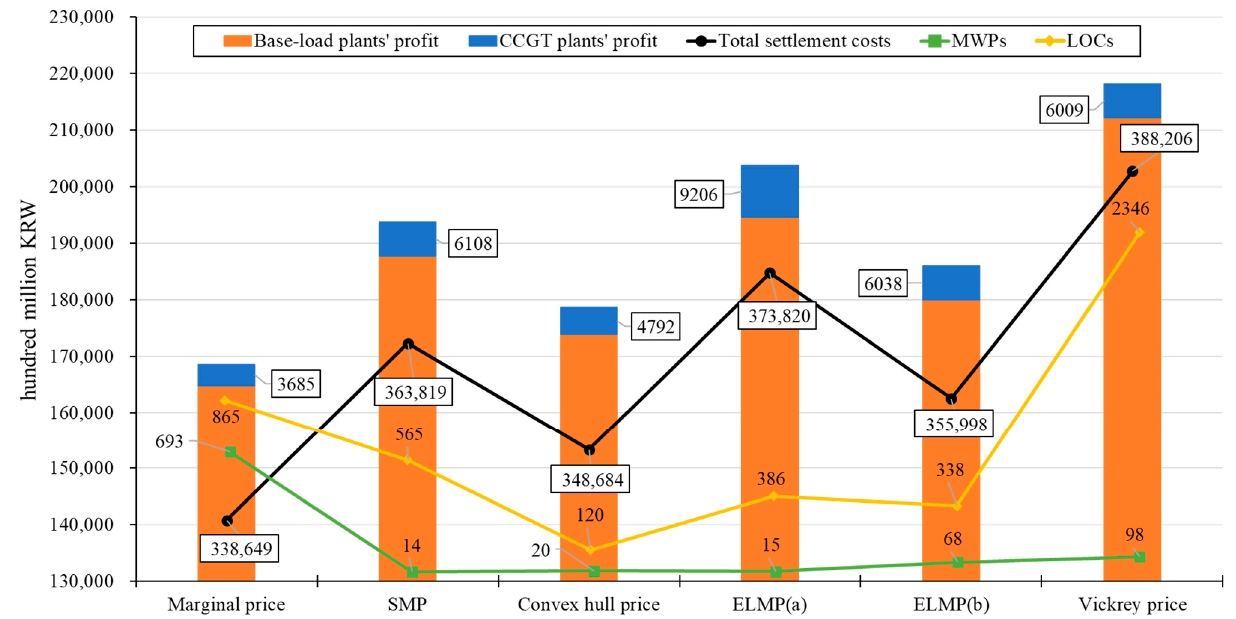
Figure 7. Comparison of the settlement costs and profits by market price in 2017. Table 6. Market price comparison by demand level in 2017 (KRW/kWh). Pricing